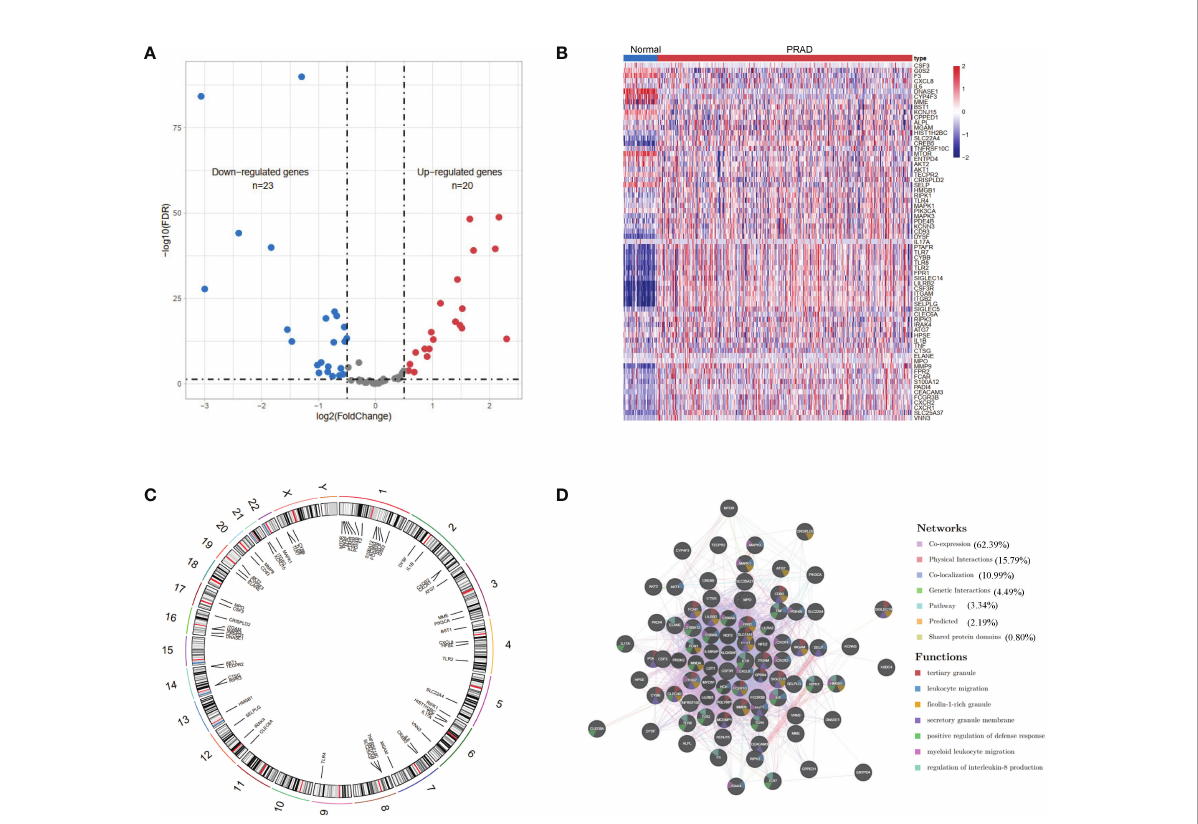
FIGURE 1 The landscape of neutrophil extracellular trap-associated genes in the TCGA-KIRC. (A) Volcano plot and (B) heatmap of 69 NET-associated genes in ccRCC and non-tumor samples. (C) The location of the NET-associated genes on different chromosomes. (D) GeneMANIA gene – gene interaction network showed the correlation among different